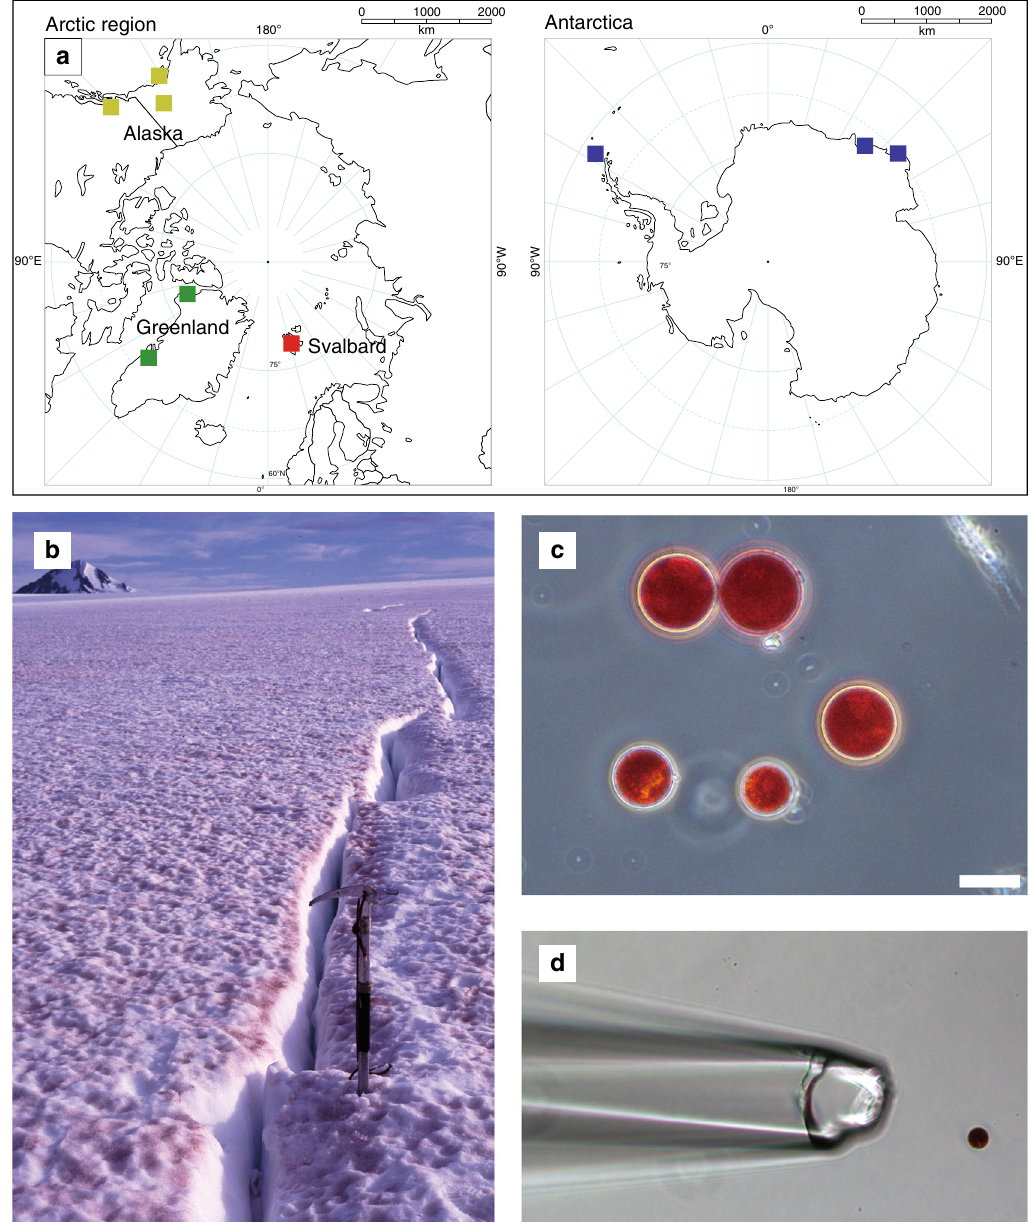
Fig. 1 Sampling sites and red-pigmented green algae causing red snow phenomena. a Map showing the locations of red-snow sampling sites. b Representative photograph of red snow on Harding Ice fi eld in Alaska. c Microscopic view of the dominant snow algae contained in the red-snow samples. Scale bar, 20 µ m. d An isolated cell of a red-snow alga used for single-cell PCR. To con fi rm that the sequences were obtained from red-snow algae, single cells from the red-snow samples were manipulated by micromanipulator system. Maps in panel A sourced from MAPIO WORLD, DesignEXchange Co.